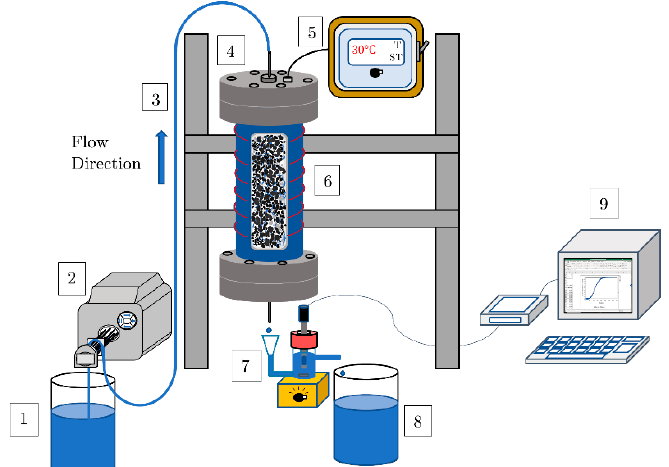
Figure 3. Illustration of the experimental set-up used to conduct tracer tests on the packing materials. It consisted of a (1) 20 L feed tank, (2) peristaltic pump, (3) tubing, (4) cylindrical test column, (5) temperature control unit, (6) heating coils, (7) conductivity measurement cell, (8) 20 L effluent tank, and (9) a desktop computer with data logging software (Graphical Analysis 4).